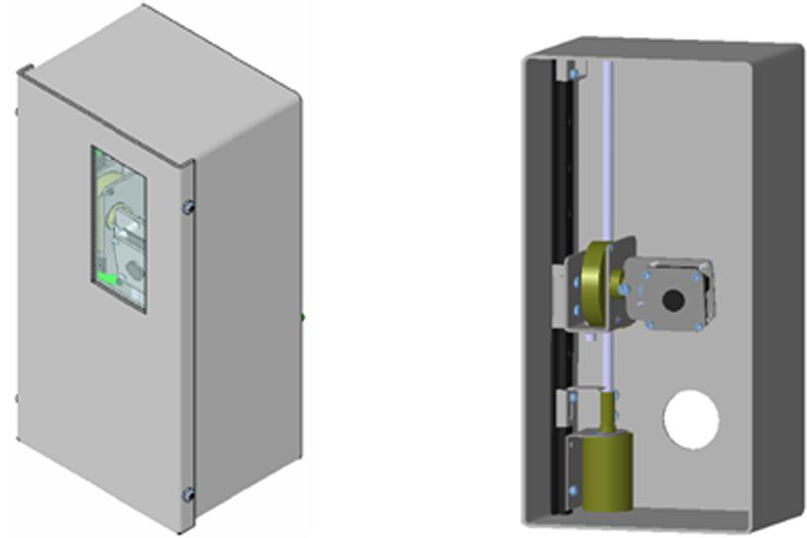
Figure 3. Web camera housing consisting of a guide rail, threaded rod, limit switch, lift support, electrical engines and web